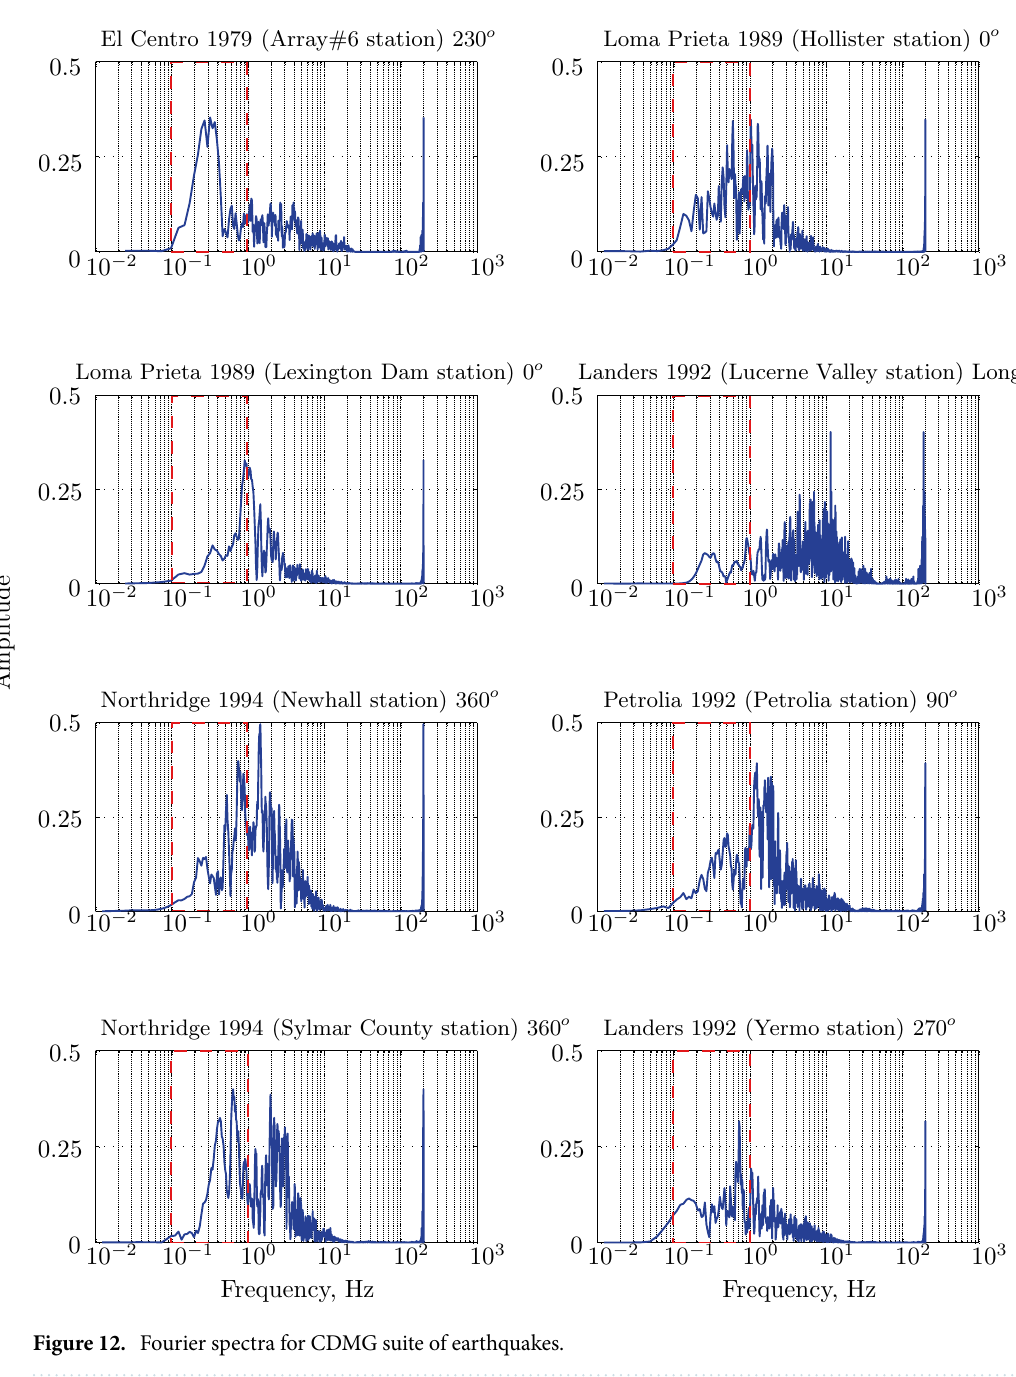
Figure 12. Fourier spectra for CDMG suite of